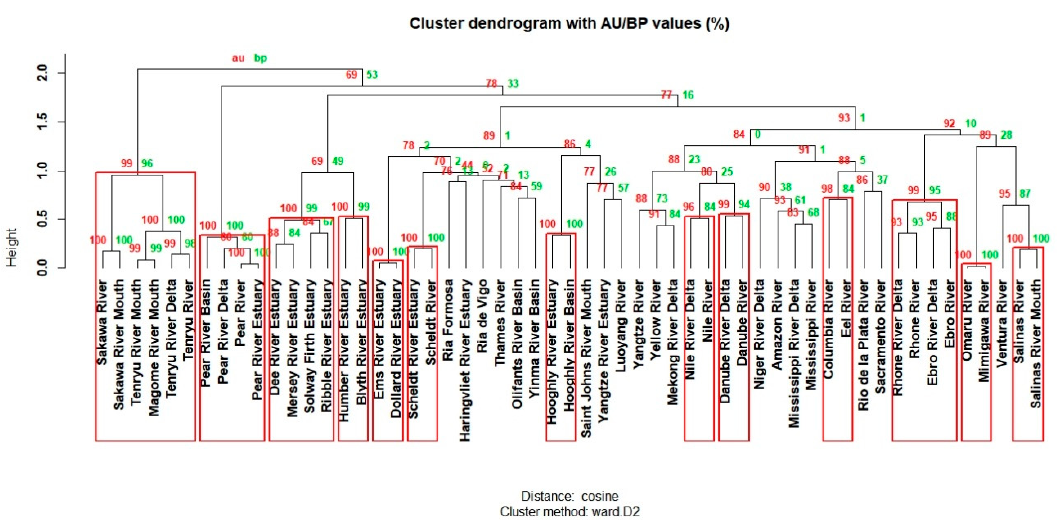
Figure 4. Dendrogram of the hierarchical clustering of the 55 named rivers with 13 clusters.